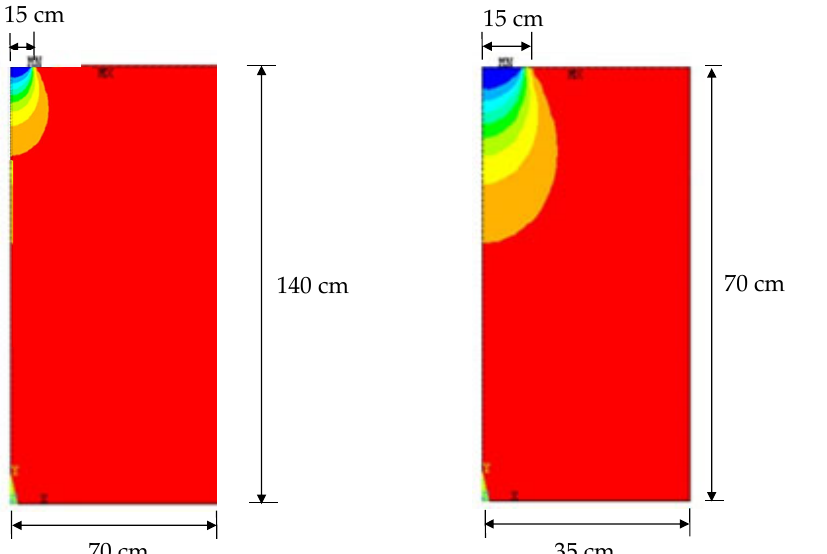
Figure 17. Vertical stress values obtained from analysis of the boundary effect.